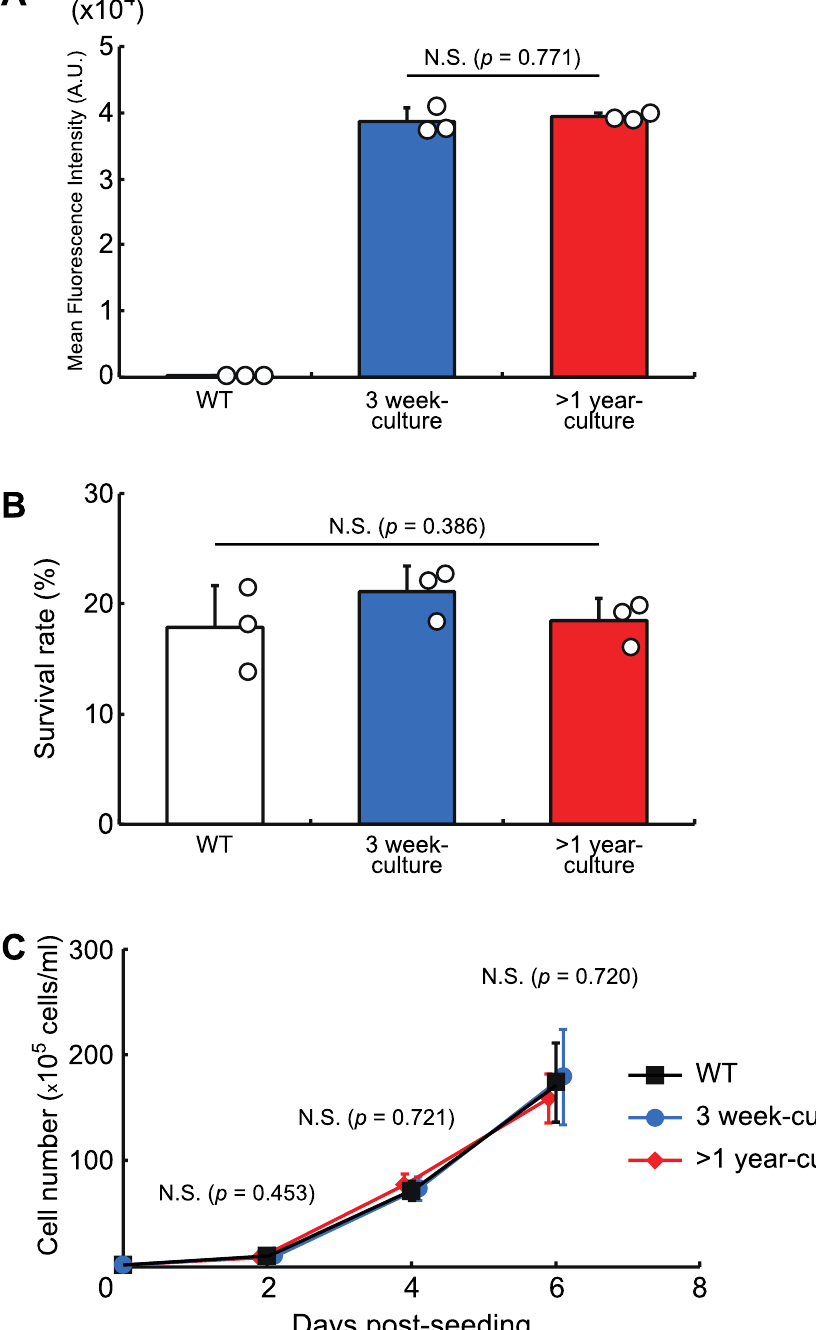
Figure 4. The effects of long-term culture after knock-in at the GSH, Chr1:21164645. ( A ) AcGFP1- expression stability after more than one year in culture without zeocin. ( B ) Cell survival rate following desiccation–rehydration treatment after more than one year in culture without zeocin. ( C ) Cell proliferation rate after more than one year in culture without zeocin. Values are expressed as mean ± SD; n = 3 in each group in ( A , B ); n = 4 in each group in ( C ). N.S., not